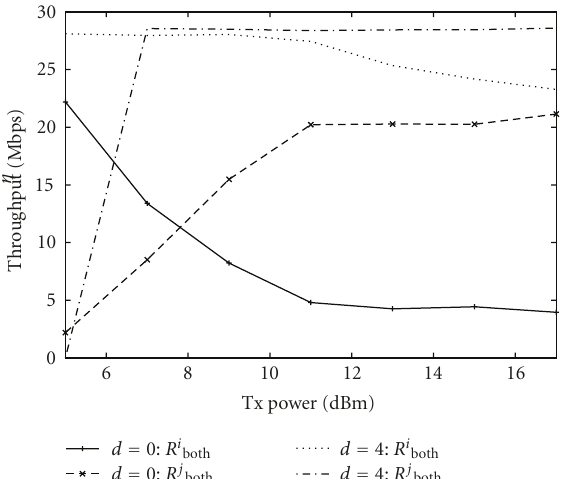
Figure 19: Close links, 802.11a: impact of channel separation and transmitted power on bandwidth